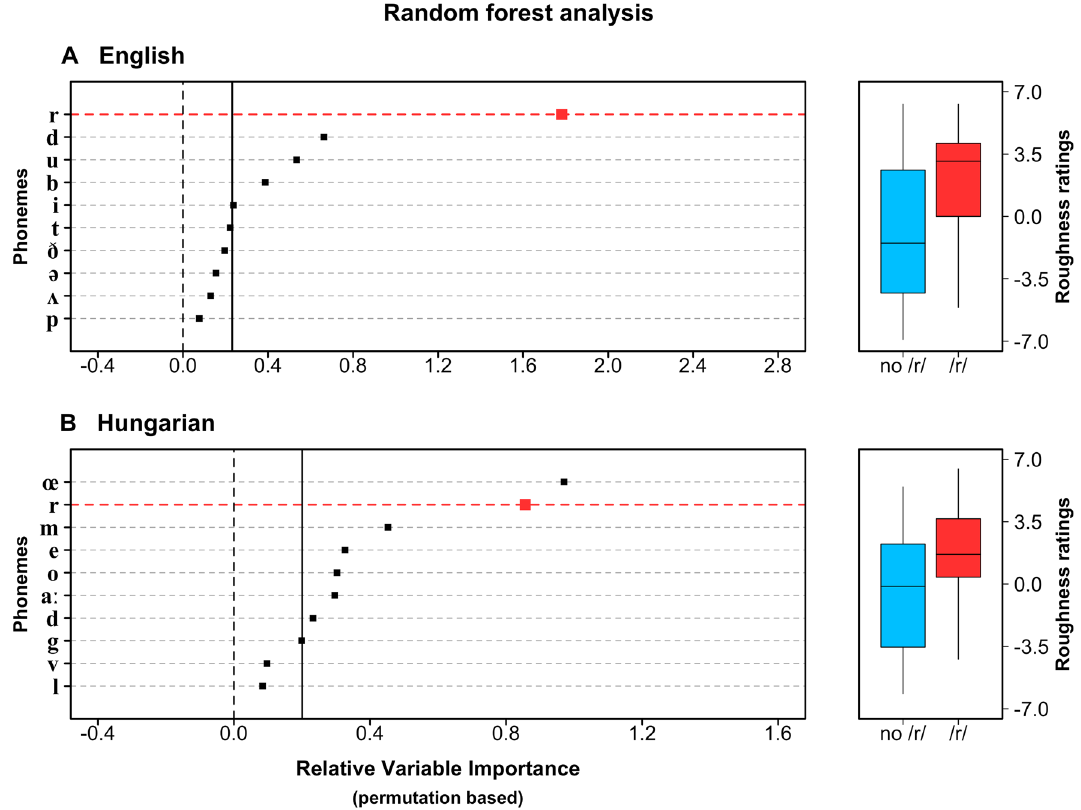
Figure 1. How phonemes relate to roughness ratings. Left: The ten most predictive phonemes in a random forest analysis for ( a ) English and ( b ) Hungarian; the vertical black line corresponds to the absolute value of the least predictive phoneme, which is a heuristic cut-off rule for predictors that do not contribute 42 . Right: Boxplots (whiskers = smallest, largest value within 1.5 × IQR) for words with and without /r/ in ( a ) English and ( b )